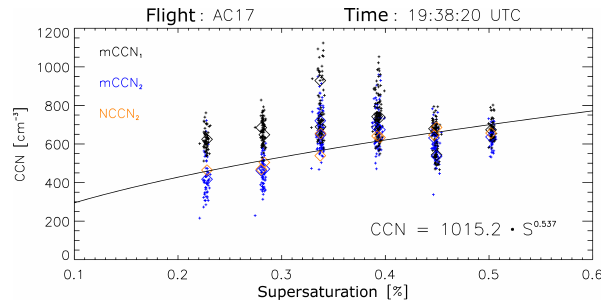
Figure 9. A comparison of the CCN spectra derived from the two CCN counter columns onboard the HALO aircraft during flight AC17. Black (blue) smaller dots indicate CCN 1 (CCN 2 ) mea- surements for each second. Large diamonds in black (blue) indicate the mCCN 1 (mCCN 2 ) for each time step of measurements. The or- ange large diamonds indicate the NCCN 2 values that are used to fit the power-law equation for the group of measurements, which is shown in the lower right corner of the plot. The standard error for the CCN spectra derived is shown in Table 2.